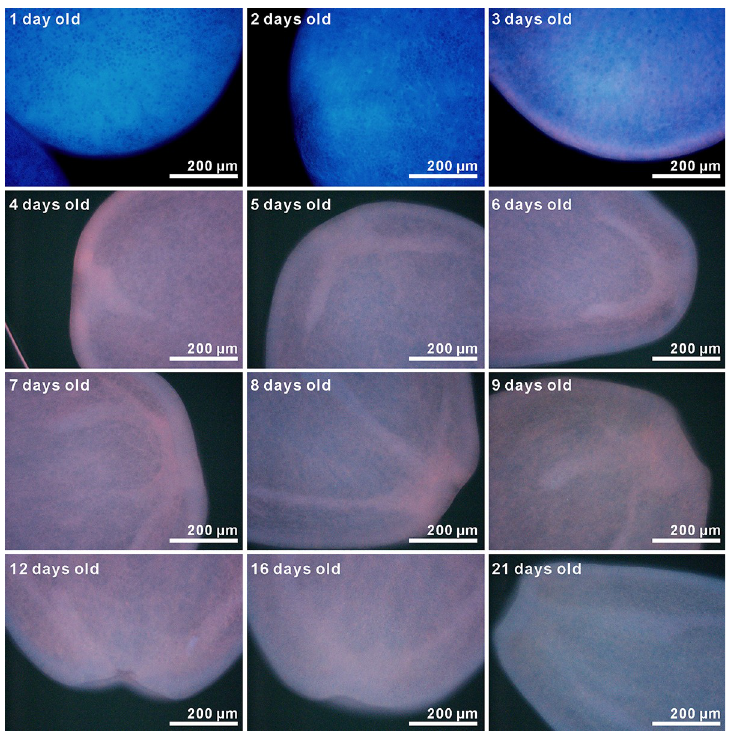
Fig 5. Fluorescent micrographs of A . tenuis larvae taken under UV-A excitation (Ex. 330–385 nm, Em. � 420 nm). The micrographs of one to three-day-old larvae were taken with an exposure time of 500 ms, whereas those for four- day-old or older larvae were taken with an exposure time of 50 ms and without any digital black balances. Although, the micrographs of larvae aged one to three days and those older than four days are slightly different in color, changes in larval fluorescence between four-day-old larvae and 21-day-old larvae can be confirmed visually. The brightness of micrographs for larvae aged four days old and over are increased. The original figures are shown in S2 Fig.